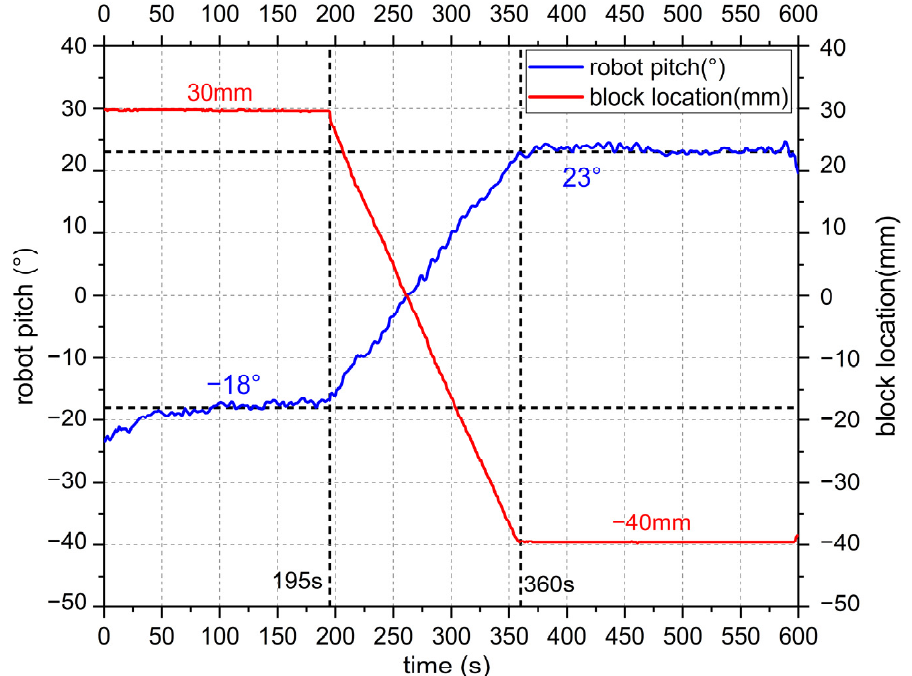
Figure 9. The location of the mass block and the robot pitch angle changed with time. We set the